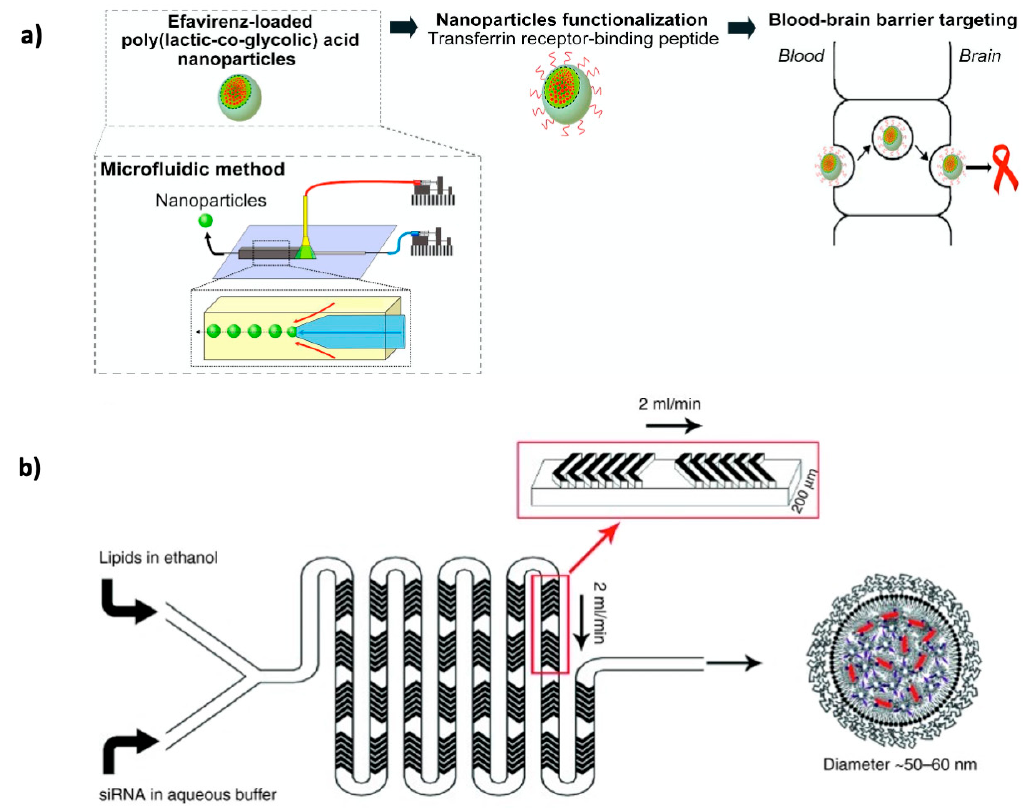
Figure 6. Production of CNS-targeted nanocarriers through microfluidic devices: ( a ) Tranferrin functionalized poly(lactic-co-glycolic) acid (PLGA) nanoparticles (NPs) for the treatment of HIV neuropathology, ( b ) siRNA-loaded lipid NPs produced with a staggered herringbone microfluidic mixer, intended to silence neuronal gene expression. Reprinted with permission from: ( a ) Martins et al. [19], ( b ) Rungta et al. [119].